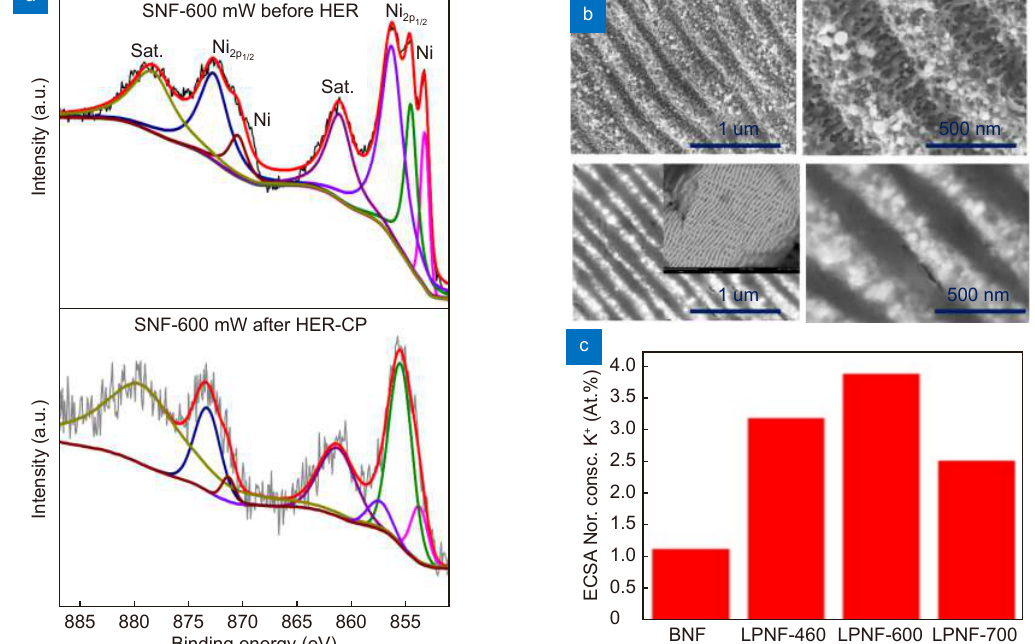
Fig. 8 | ( a ) X-ray photoelectron spectra (XPS). ( b ) SEM images. ( c ) ECSA normalized atomic concentration of K + ions at the surface of –1 V (vs. RHE) biased LPNF electrodes in 1.0 M KOH